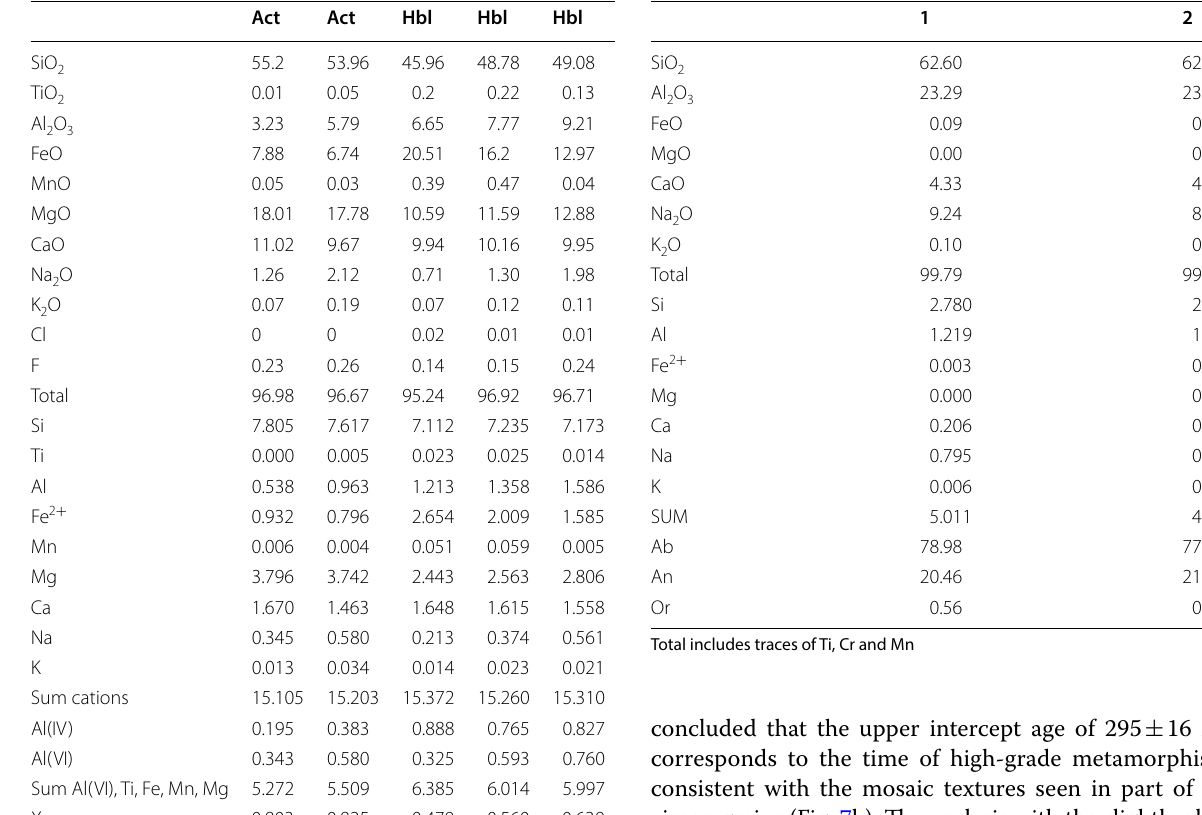
Table 4 Composition of amphiboles in eclogite facies SW9 Table 5 Composition of plagioclase in